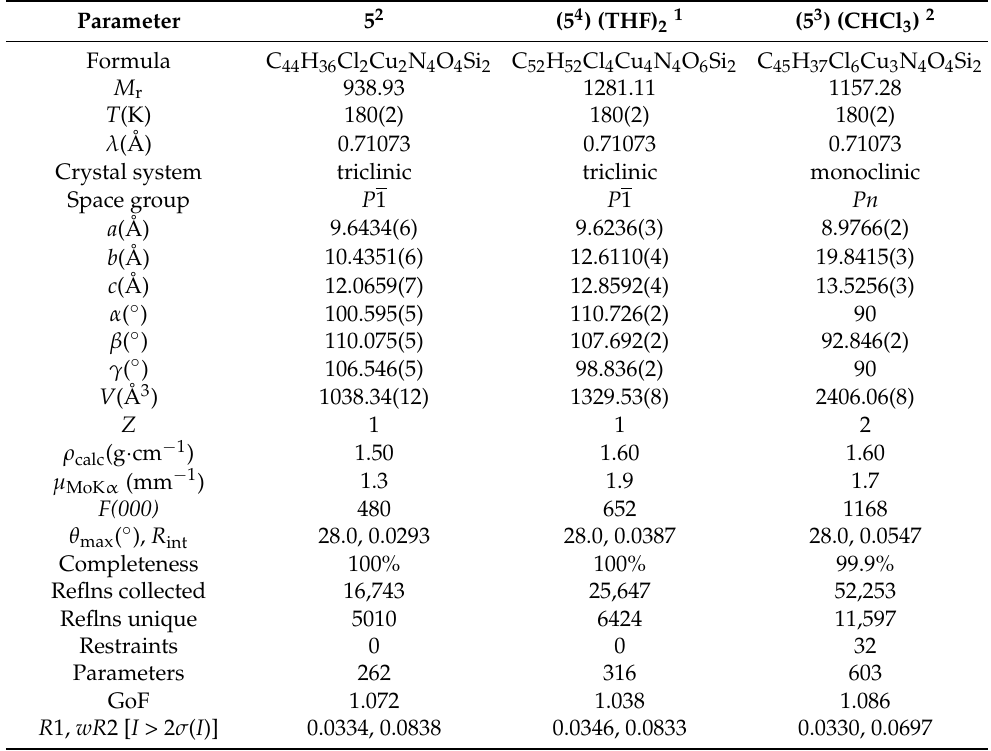
Table A4. Crystallographic data from data collection and refinement for 5 2 , ( 5 4 ) · (THF) 2 and ( 5 3 ) · (CHCl 3